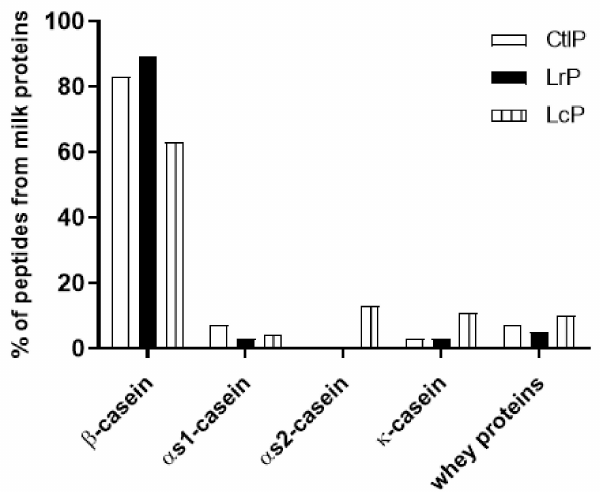
Figure 5. Histogram showing the main milk proteins from which the peptides from donkey milk inoculated with L. rhamnosus 17D10 (LrP), L. lactis subsp. cremoris 40FEL3 (LcP), and not inoculated (CtlP) were